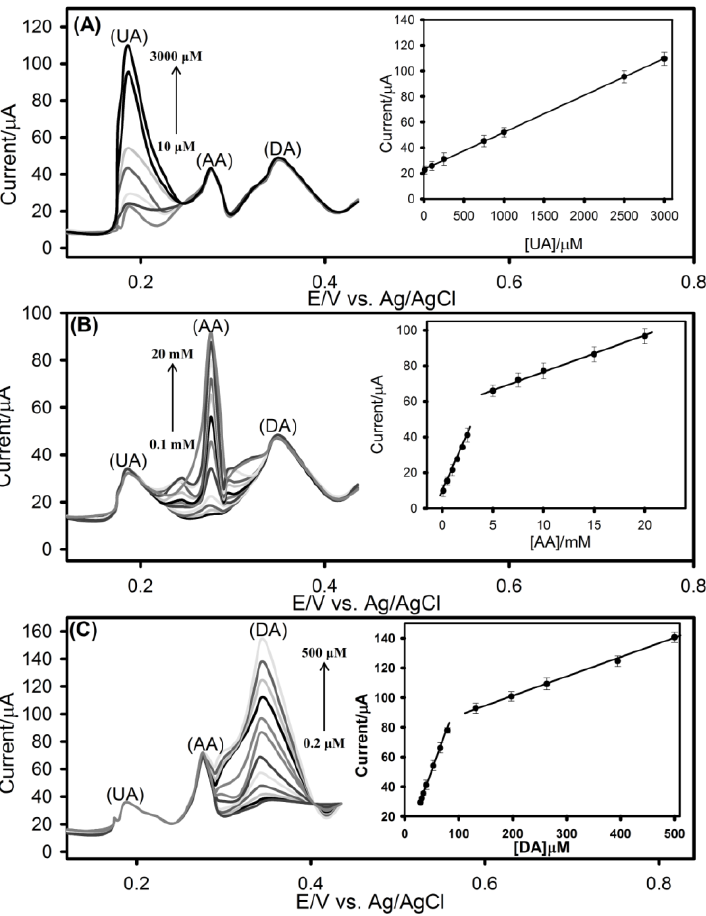
Figure 5. DPVs of UA, AA and DA at rGO-SPCE in BR buffer (pH 7.0), 50 mV·s −1 scan rate: ( A ) UA concentrations of 10.0, 100.0, 250.0, 750.0, 1000.0, 2500.0 and 3000.0 μM in the presence of 2.5 mM AA and 50.0 μM DA; ( B ) AA concentrations of 0.1, 0.5, 1.0, 1.5, 2.0, 2.5, 5, 7.5, 10.0, 15.0, and 20.0 mM in the presence of 250.0 μM UA and 50.0 μM DA; and ( C ) DA concentrations of 0.2, 20.0, 30.0, 40.0, 50.0, 70.0, 80.0, 120.0, 200.0, 250.0, 400.0 and 500.0 μM in the presence of 250.0 μM UA and 2.5 mM AA. Inserts: I p vs. concentration.